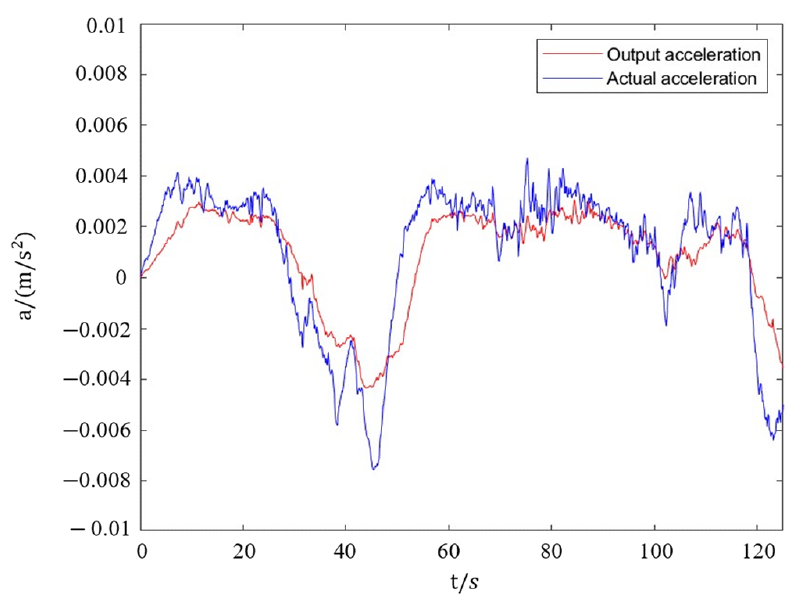
Figure 17. Platform output acceleration.